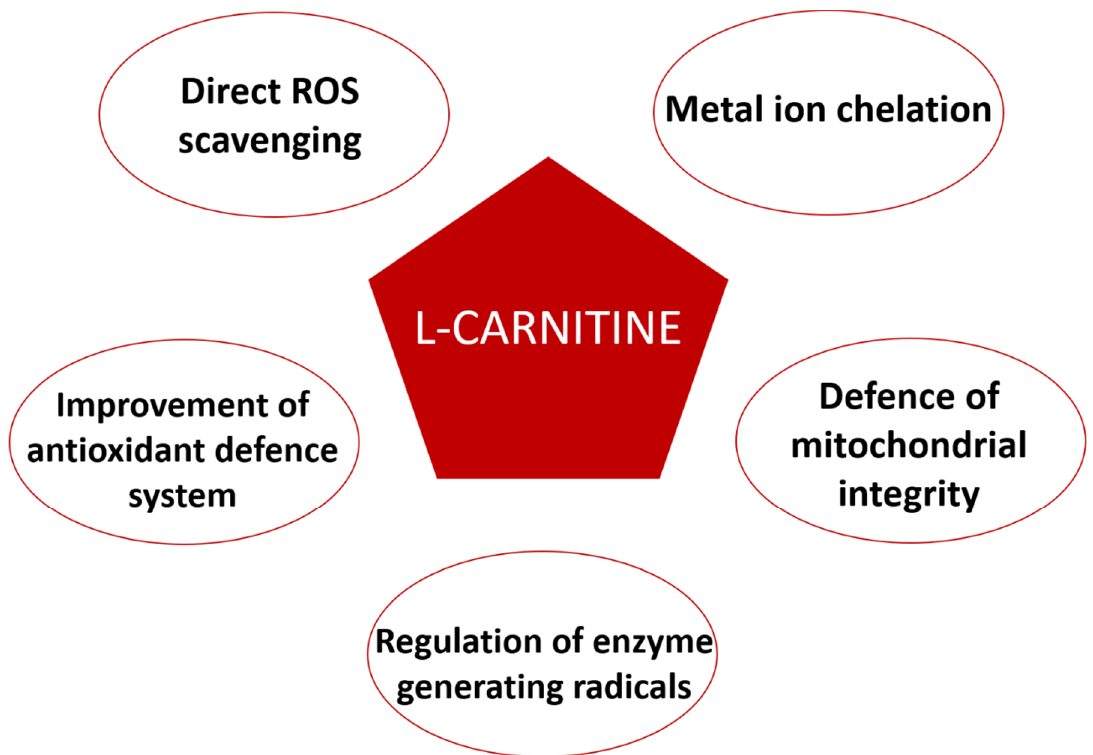
Figure 4. An overview of the antioxidant properties of L-carnitine.